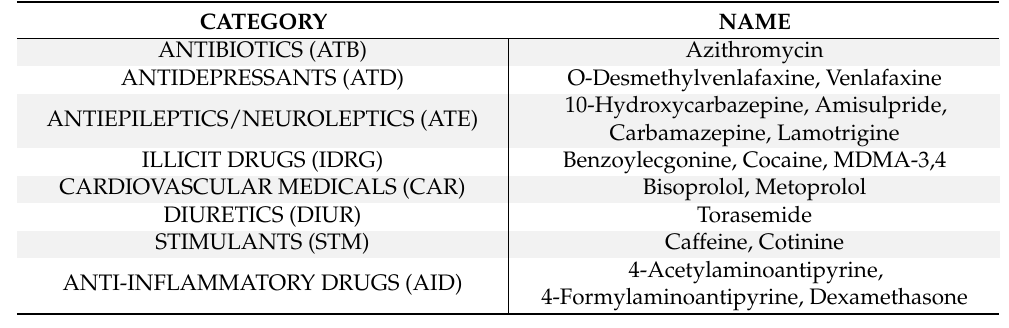
Table 1. Eighteen chemicals analyzed in this study grouped in eight categories (ATB, ATD, ATE, IDRG, CAR, DIUR, STM, and